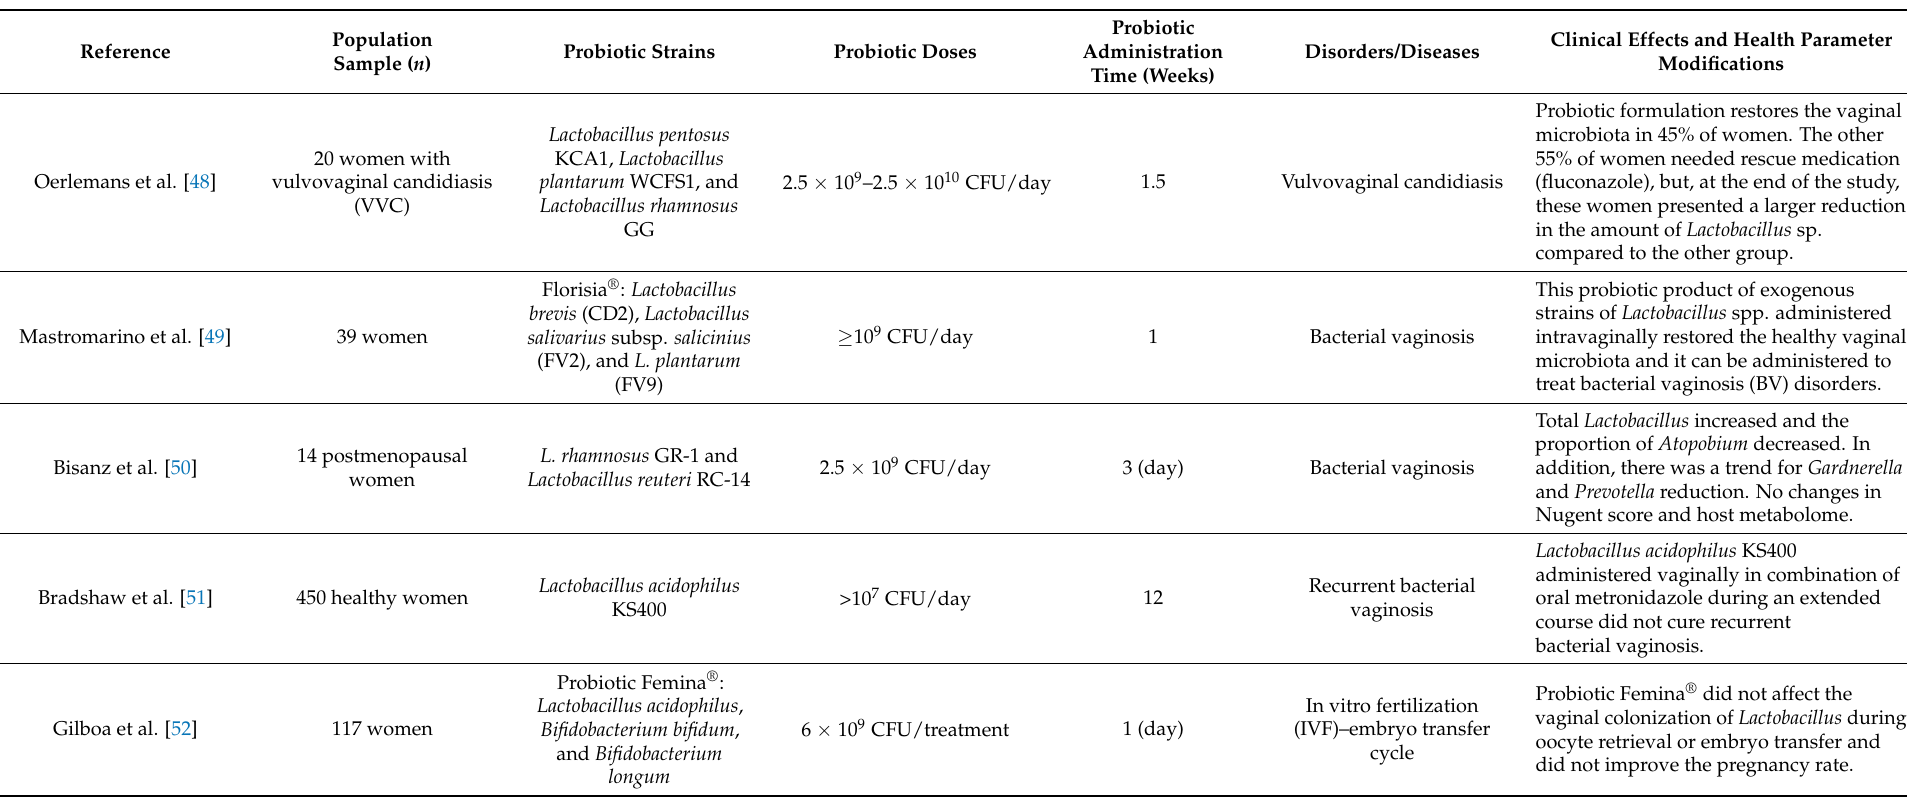
Table 2. Effects of vaginal probiotic strains administered in clinical trials in reproductive and fertility-related disorders and their relevant clinical